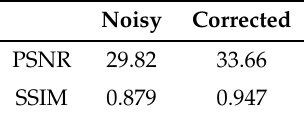
Table 7. PSNR (dB) and SSIM results for